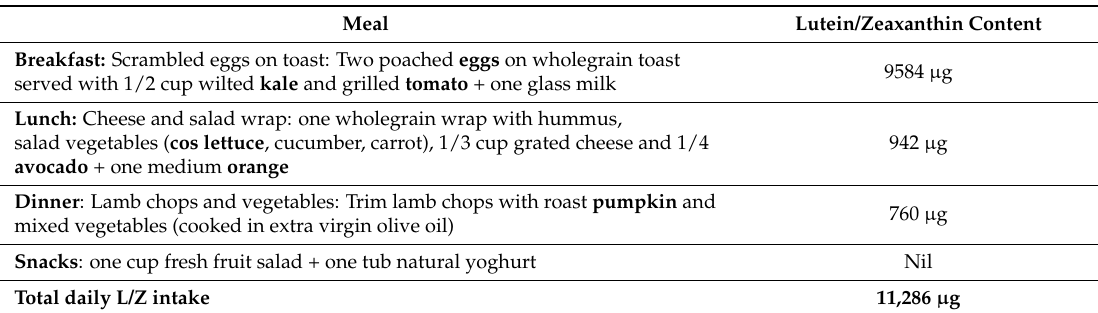
Table 7. Example meal plan with calculated L/Z content >10